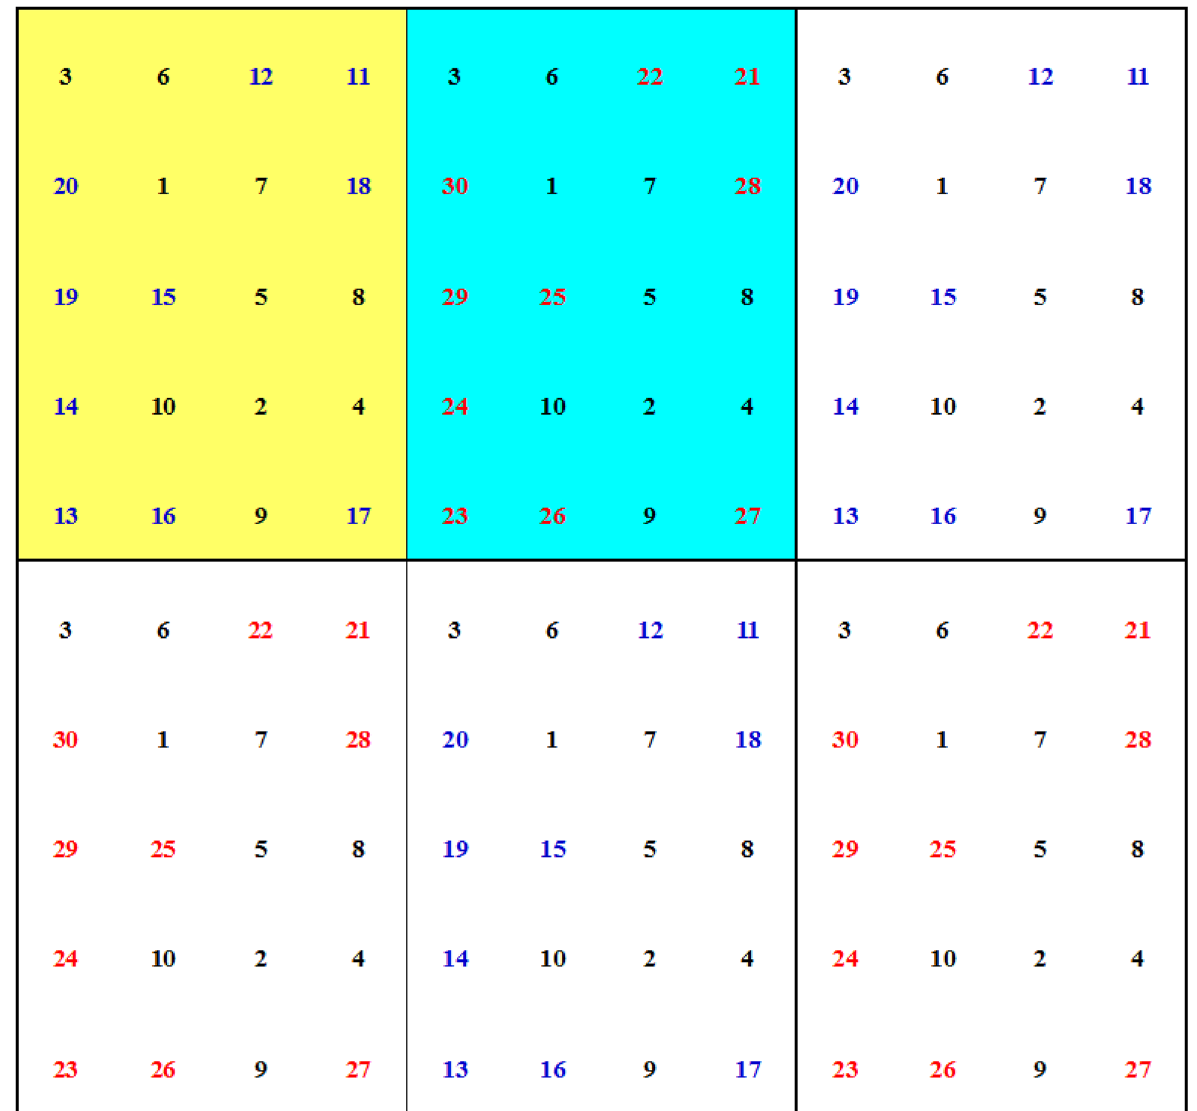
Fig 5. Field deployment of the second-generation Chinese pine seed orchard in Xixian. Note: Number represents family no. Families in the same rectangle belong to the same block. Families in black, blue, and red fonts are the best, moderate, and control- pollinated families. The yellow and blue shaded areas represent the two kinds of complete blocks, and six blocks are shown.